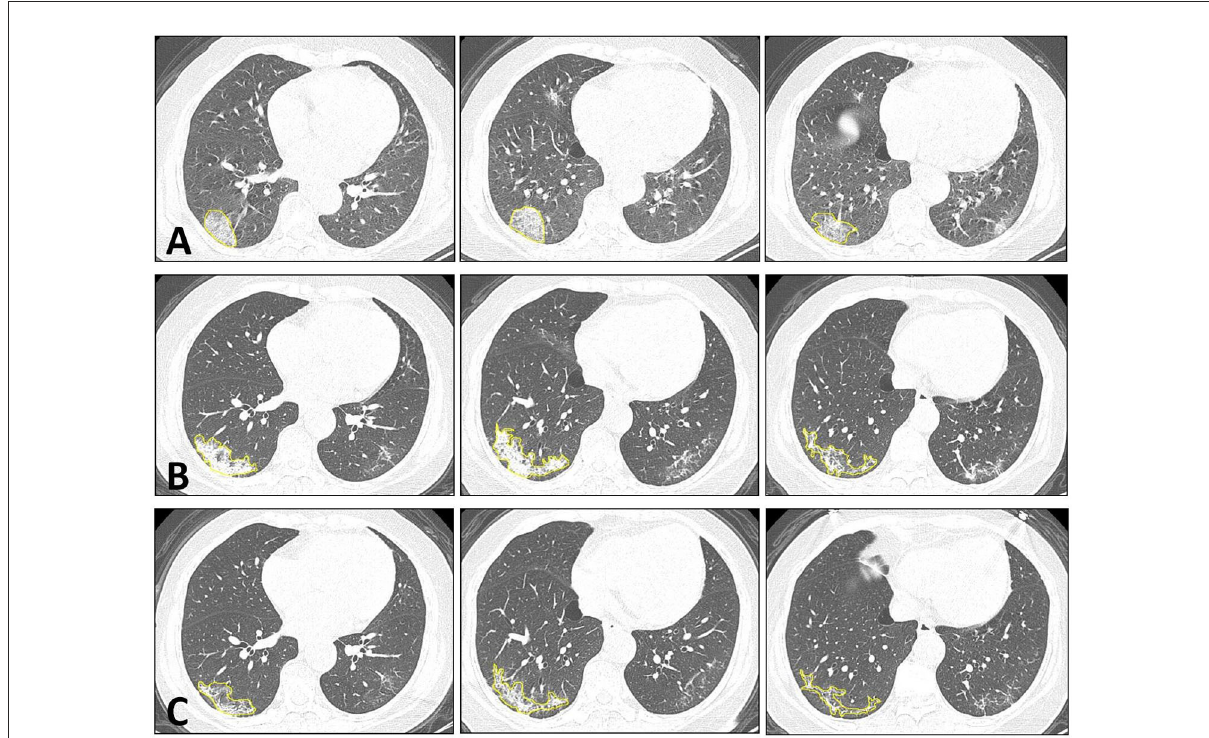
FIGURE1 Dynamic changes of CT imaging in a 66-year-old female patient. At each time point, three selected CT slices are shown. (A) The baseline CT is taken approximately 3 days after the onset of infection. In the lateral and posterior basal segments of the right lower lung, increased ground-glass density is noted, which also exhibits the reversed halo sign and crazy-paving pattern in the lesion. (B) The first F/U is taken 12 days after the baseline CT. The lesion shows a higher density of consolidation change compared to the baseline. The overall infection area is increased, but the arc-shaped clearance near the pleura is noted, which indicates the beginning of the absorption phase. (C) The second F/U is taken 8 days after the first F/U. The lesion shows an obvious absorption, with smaller areas and a lower density.